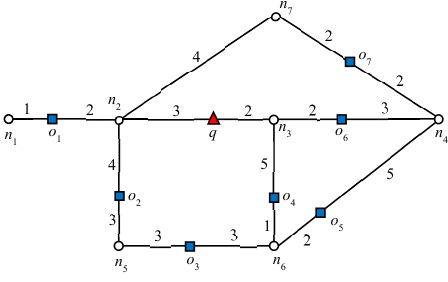
Figure 1. Example of a road network. Table 1. Summary of notations used in this